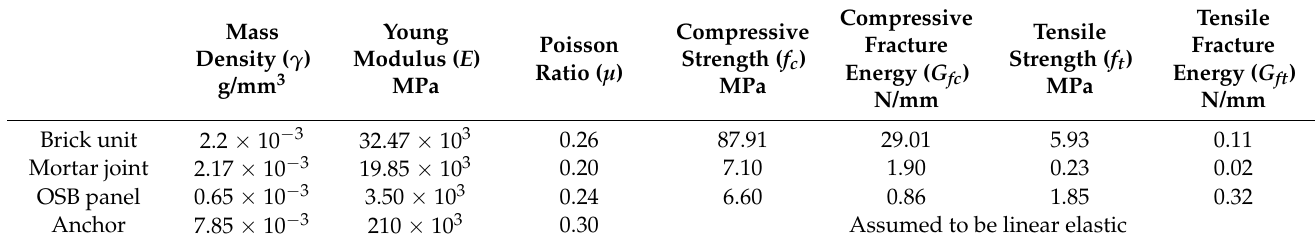
Table 5. Input material properties of components obtained via